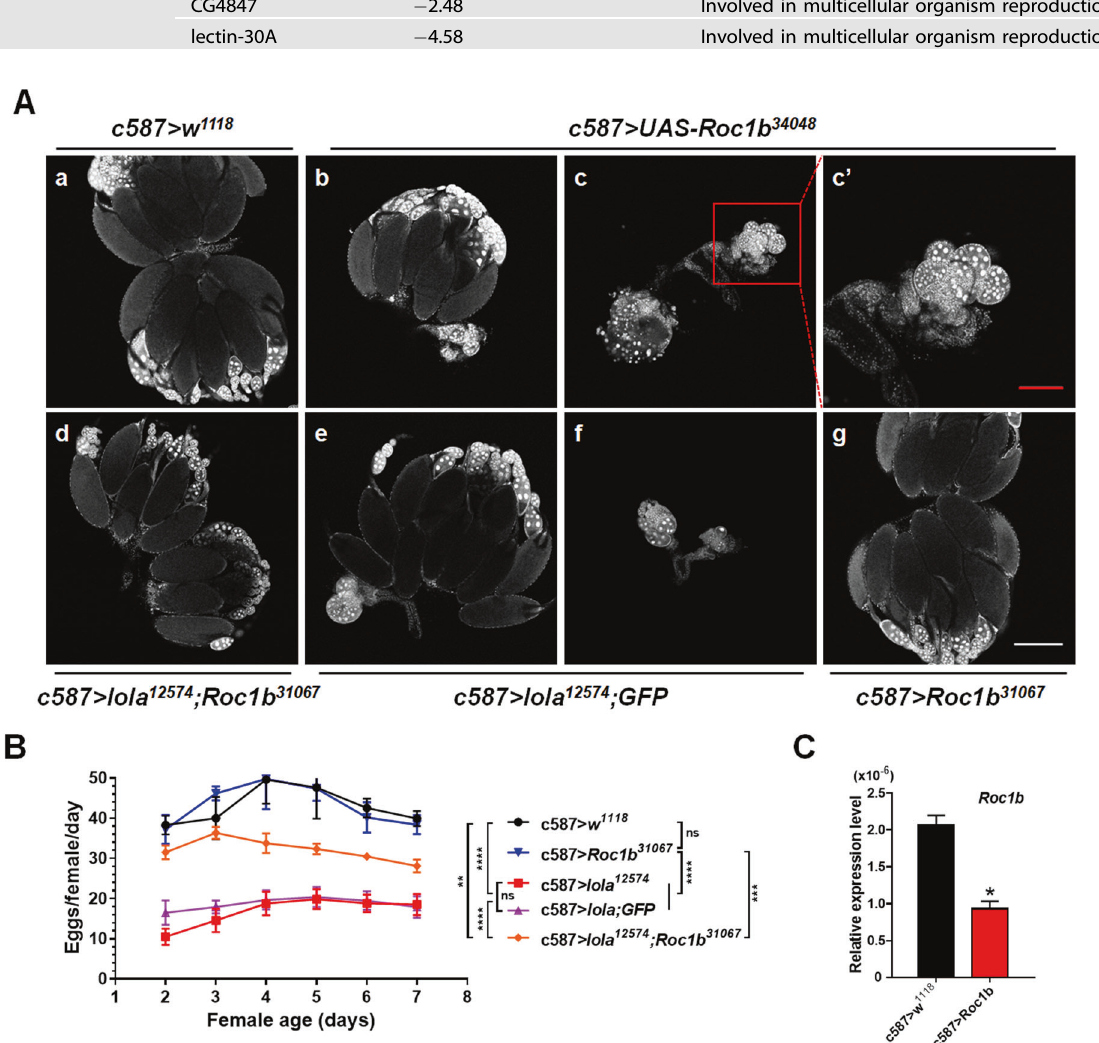
Fig. 7 Lola regulates ovarian morphogenesis by suppressing Roc1b expression. A Phenotypes of ovaries from the c587 > w 1118 , c587 > UAS- Roc1b 34048 , c587 > lola 12574 ;Roc1b 31067 , c587 > lola 12574 ;GFP and c587 > Roc1b 31067 lines. a Ovaries with normal size and number of ovarioles from the c587 > w 1118 control. b , c Overexpression of Roc1b resulted in one smaller ovary with fewer ovarioles ( b ) or a pair of smaller ovaries with fused egg chambers ( c ), which mimic the phenotypes of lola 12574 RNAi. d Knockdown of Roc1b in the c587 > lola 12574 RNAi line rescued defects in ovarian morphogenesis. e , f Knockdown of GFP in the c587 > lola 12574 RNAi line resulted in one smaller ovary with fewer ovarioles ( e ) or a pair of smaller ovaries with fused egg chambers ( f ). g Ovaries with normal size and number of ovarioles from the c587 > Roc1b 31067 . c ’ Higher magni fi cation of the ovary region from c . B Knockdown expression of Roc1b in fl ies ( c587 > Roc1b 31067 ) did not have an effect on female fertility, while knockdown expression of Roc1b in the c587 > lola 12574 RNAi line increased female fertility. C Expression of Roc1b in the ovaries of the c587 > Roc1b 31067 and c587 > w 1118 control lines. Signi fi cant difference was determined by the student ’ s t-test and indicated by * p < 0.05, ** p < 0.01, *** p < 0.001, **** p < 0.0001, ns for non-signi fi cant. Scale bar: 100 µm in a – g , 300 µm in c ’